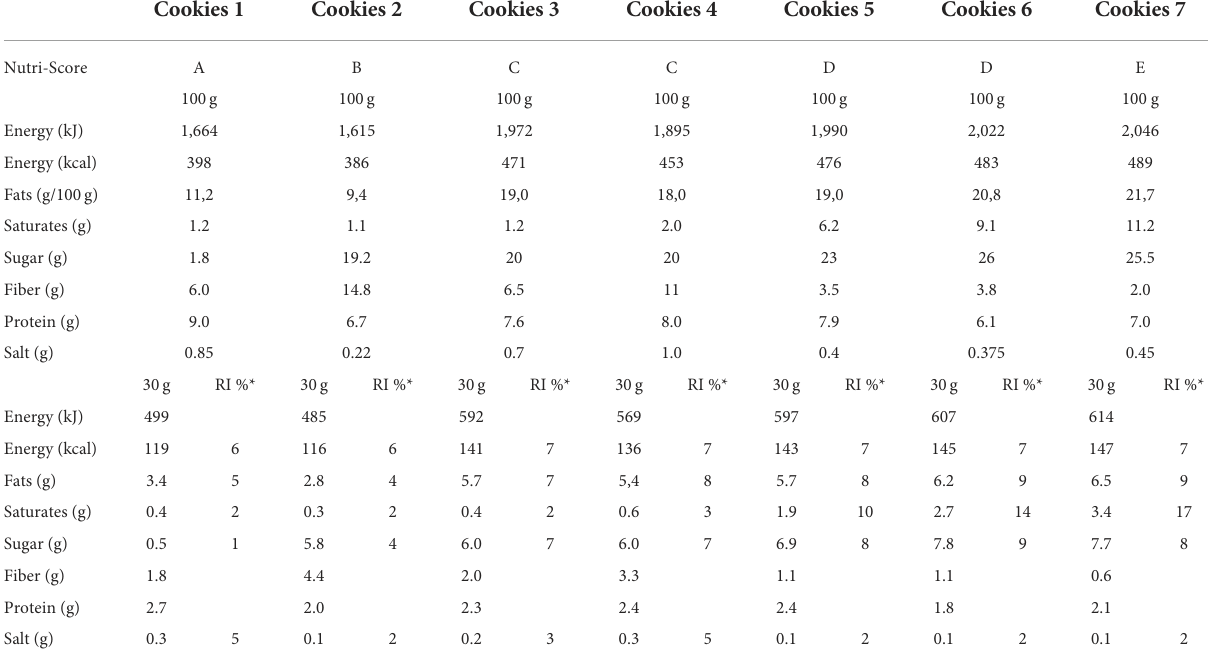
TABLE 4 Energy and nutrient content of cookie items sold on the Italian market, per 100g with different calculated Nutri-Score, and per portion (30g) with percentage contribution of each portion to Reference Intakes for energy and nutrients, as in NutrInform Battery.